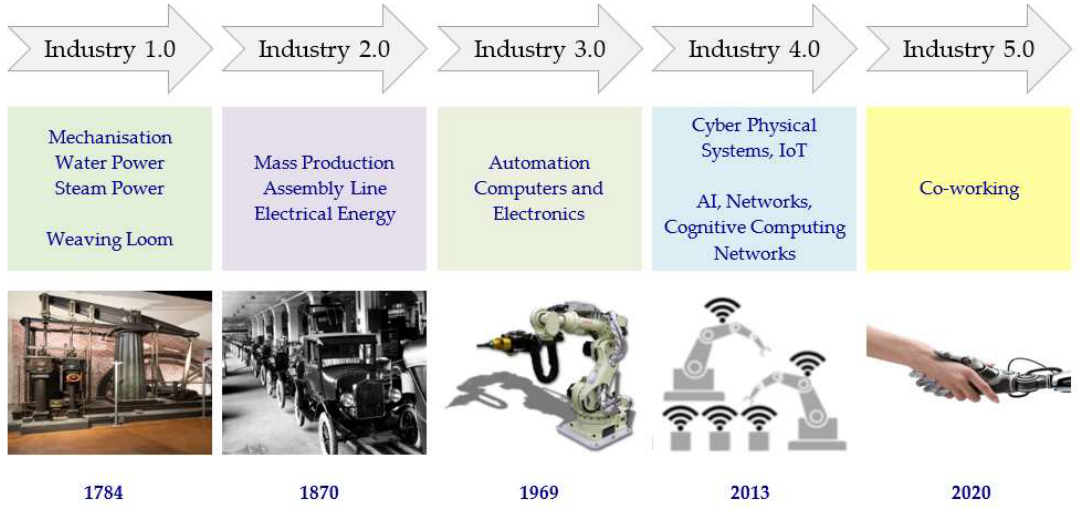
Figure 12. The Five Stages of the Industrial Revolution. Adapted from: [81].